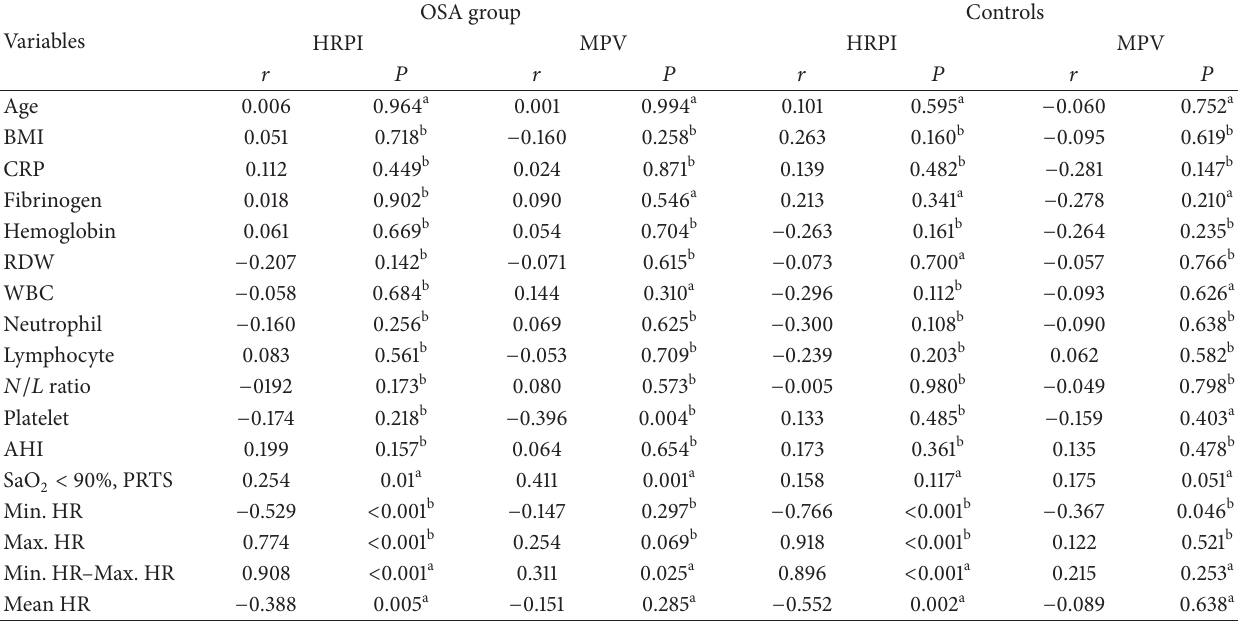
Table 2: Correlations between HRPI, MPV, and other variables in the OSA and in the control group.